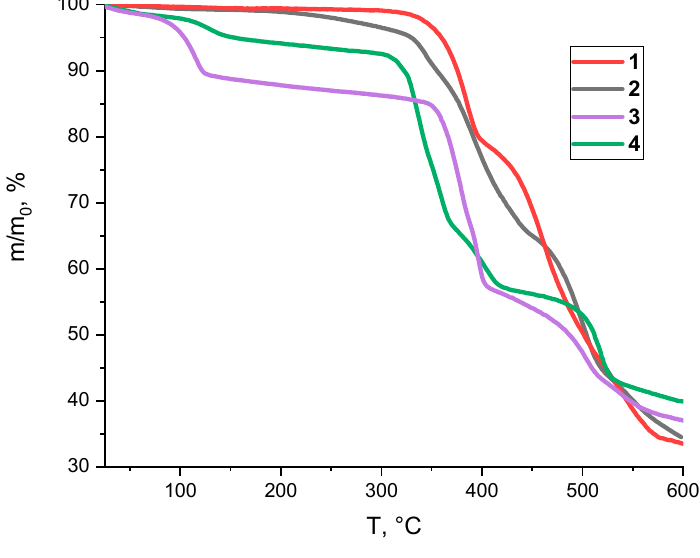
Figure 3. TG plots for compounds 1 – 4 .